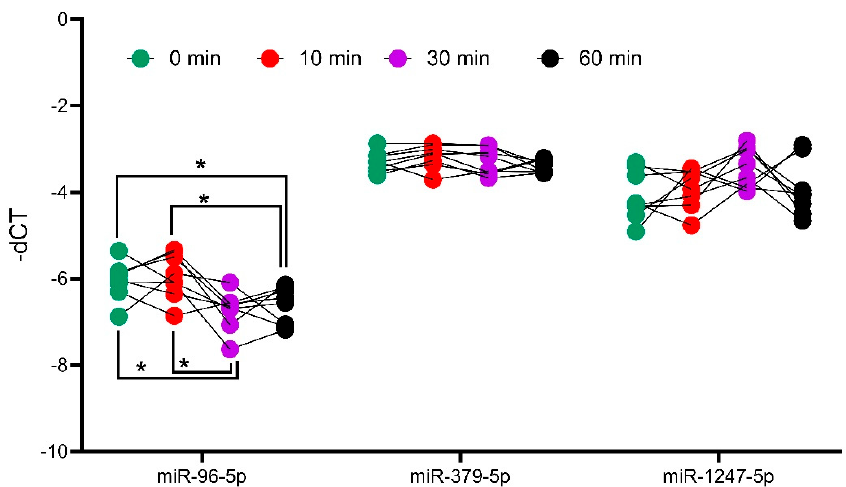
Figure 5. Analysis of miRNA expression in ACTH stimulated mice tissue. QPCR analyses of positive controls, miR-96-5p, and candidates miR-379-5p and miR-1247-5p. Mice were injected with ACTH, and adrenals were collected at different timepoints to assess the impact of ACTH on miRNA expression. Data are represented as mean ± standard deviation (SD) of − dCT values. Housekeeping gene: miR-26a-5p. Statistics: ANOVA test with Bonferroni correction to detect significant differences between patient groups with at least a significance of p -value < 0.05 (*).